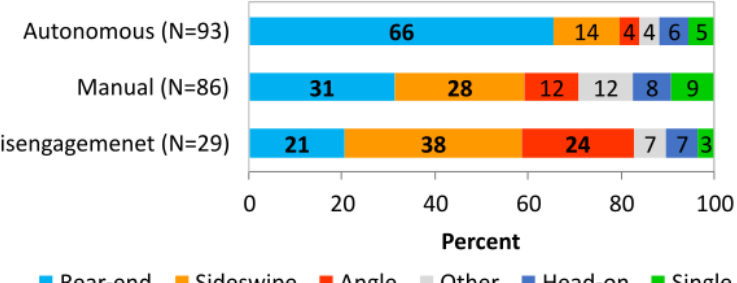
Figure 2 Collision types by AV